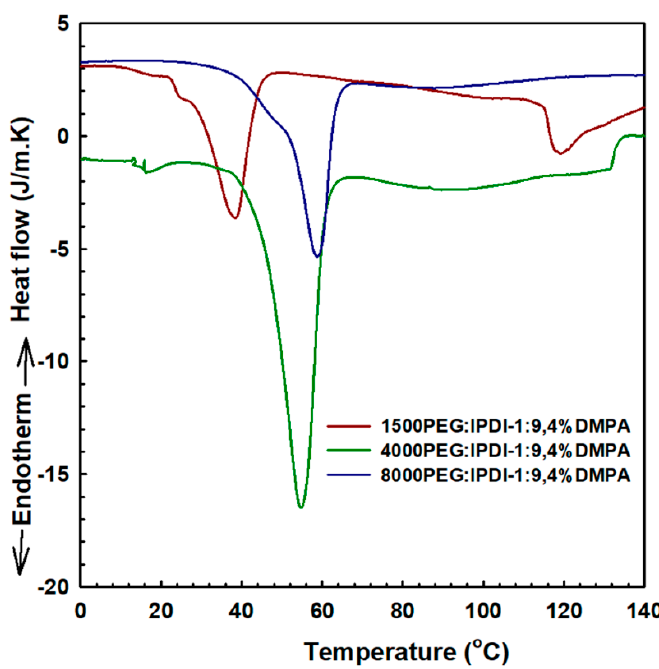
Figure 9. Thermophysical property of WSPU samples.